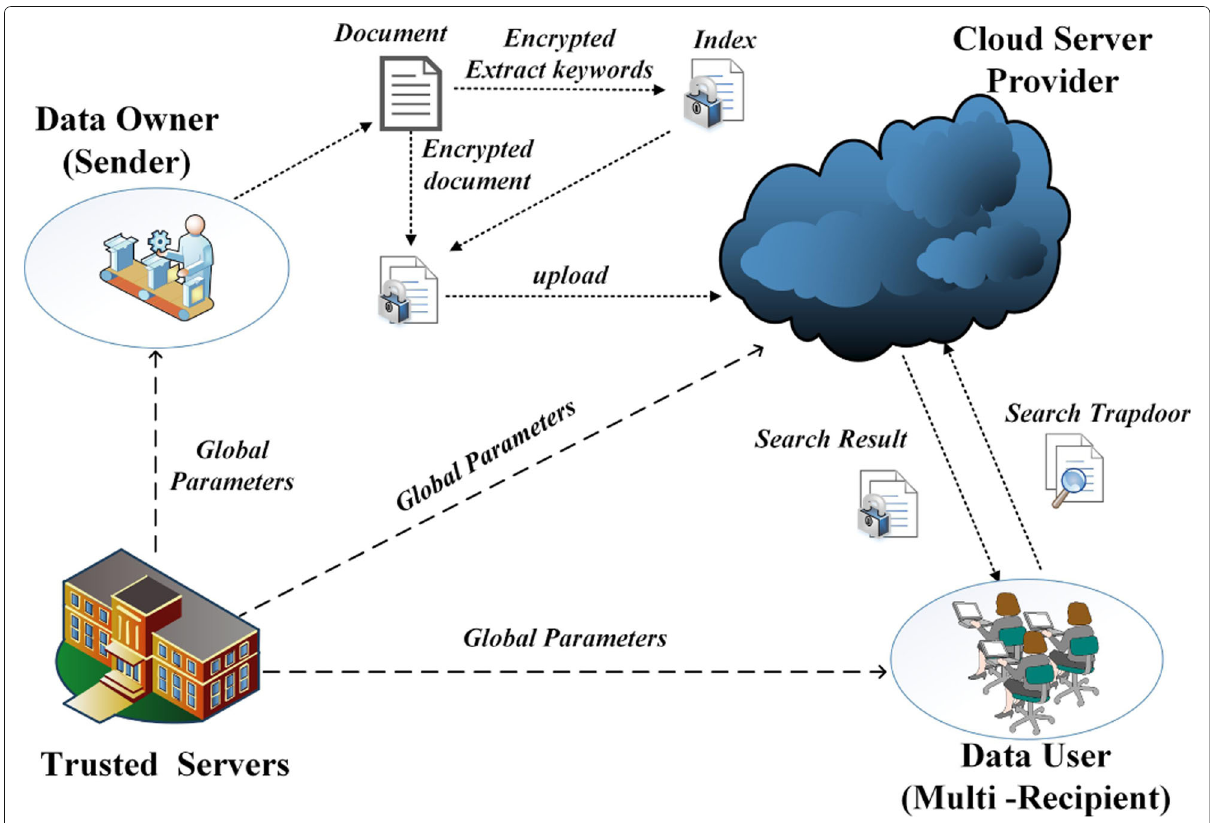
Fig. 2 System model of MREKS